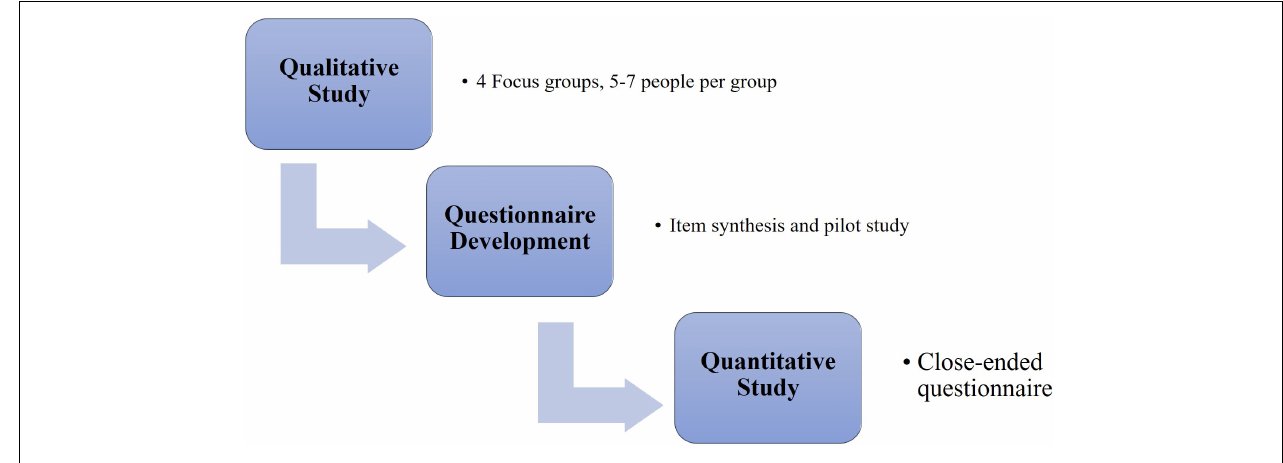
FIGURE 1 | Framework of the study.